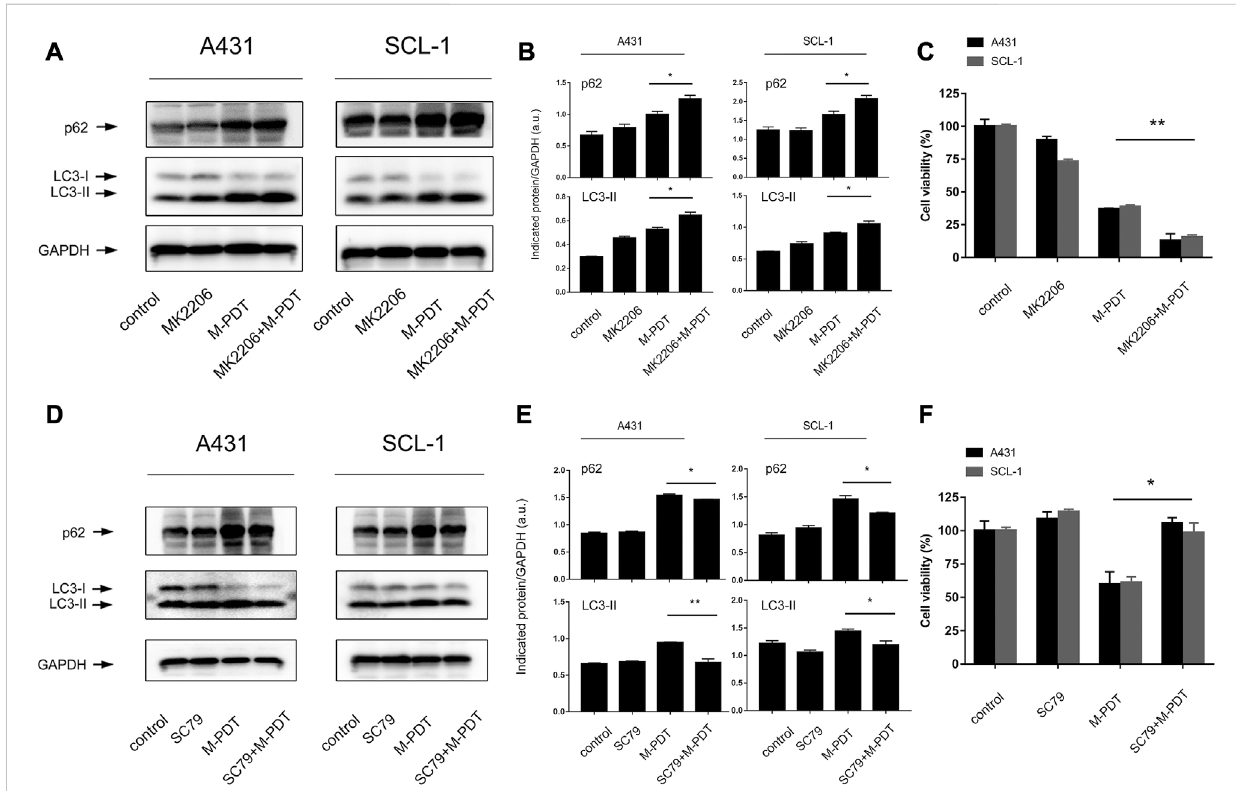
FIGURE 7 Pharmacological regulation of Akt could affect M-PDT-induced accumulated autophagosomes-dependent cSCC cell viability suppression. (A, D) Western blot for indicated antibodies. GAPDH is a loading control. (B, E) The relative densities of LC3-II and p62 were semi-quanti fi ed. (C, F) Cell viability was detected by CCK8. * p < 0.05, ** p < 0.01. n =